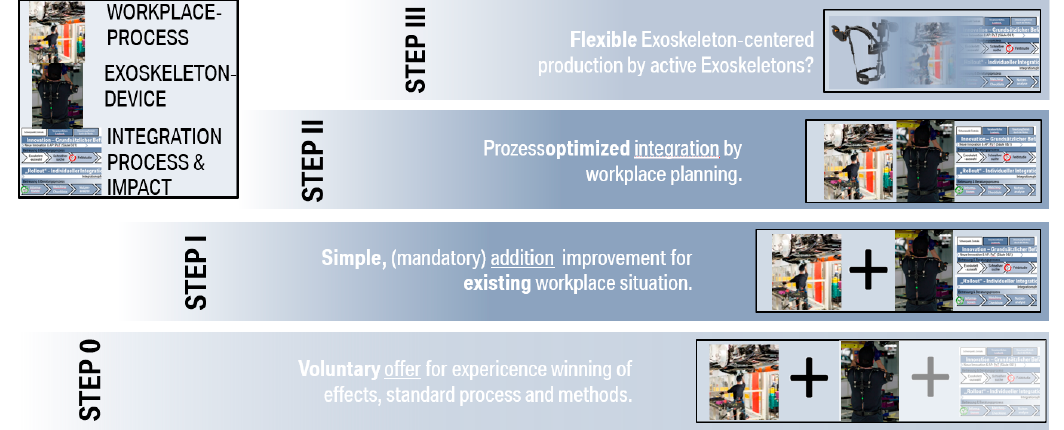
Figure 7. Step-by-step roadmap for optimized integration of exoskeleton.